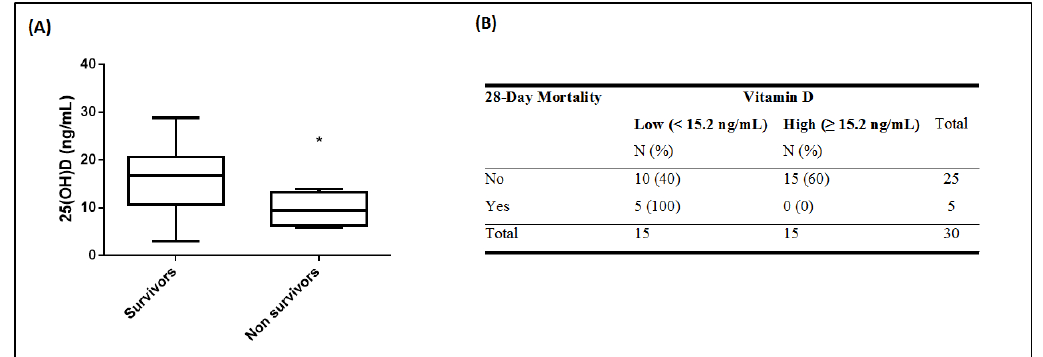
Figure 1. 25-hydroxyvitamin D and 28-day mortality. 25(OH)D levels were measured in 30 critically ill COVID-19 patients on ICU admission. Patients were subdivided in patients who died within 28 days of ICU stay (N = 5, non-survivors), and patients who survived (N = 25, survivors). 25(OH)D levels on ICU admission were compared between the two groups. A difference is observed in 25(OH)D levels on ICU admission (A: vitamin D continuous, p = 0.03; B: vitamin D categorical, p = 0.02). 25(OH)D levels in the patients were quantified in blood samples harvested on ICU admission (within the first 48 h). Two-group comparisons were performed using the non-parametric Mann–Whitney test for skewed data for continuous vitamin D variable and chi square test for categorical vitamin D variable with the two categories (cut-off = 15.2 ng / mL). Asterisk symbol (*) means p < 0.05. Line in the box: median value; box edges: 25th to 75th centiles; whiskers: range of values ( A ). Data are expressed as the number of patients (N) and percentages of totals (%) ( B ).